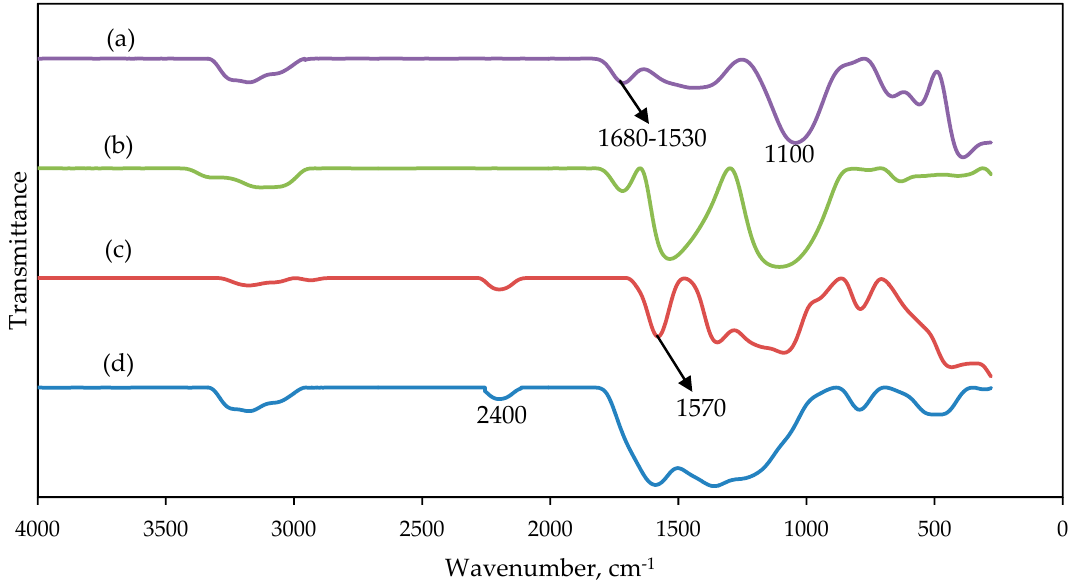
Figure 4. FTIR spectra of carbonized ( a ) PAN and ( b ) PAN / SL nanofibers; and stabilized ( c ) PAN and ( d ) PAN / SL nanofibers.